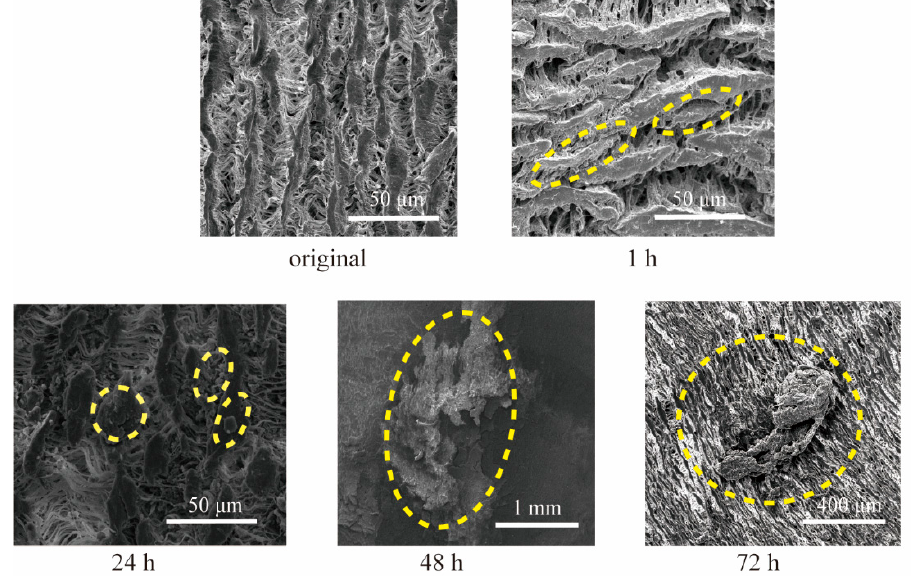
Figure 5. Thrombus formation near the joint observed by SEM. Thrombus formation was observed at each interval. However, it was not concluded that the ditch at the interface initiated the formation.